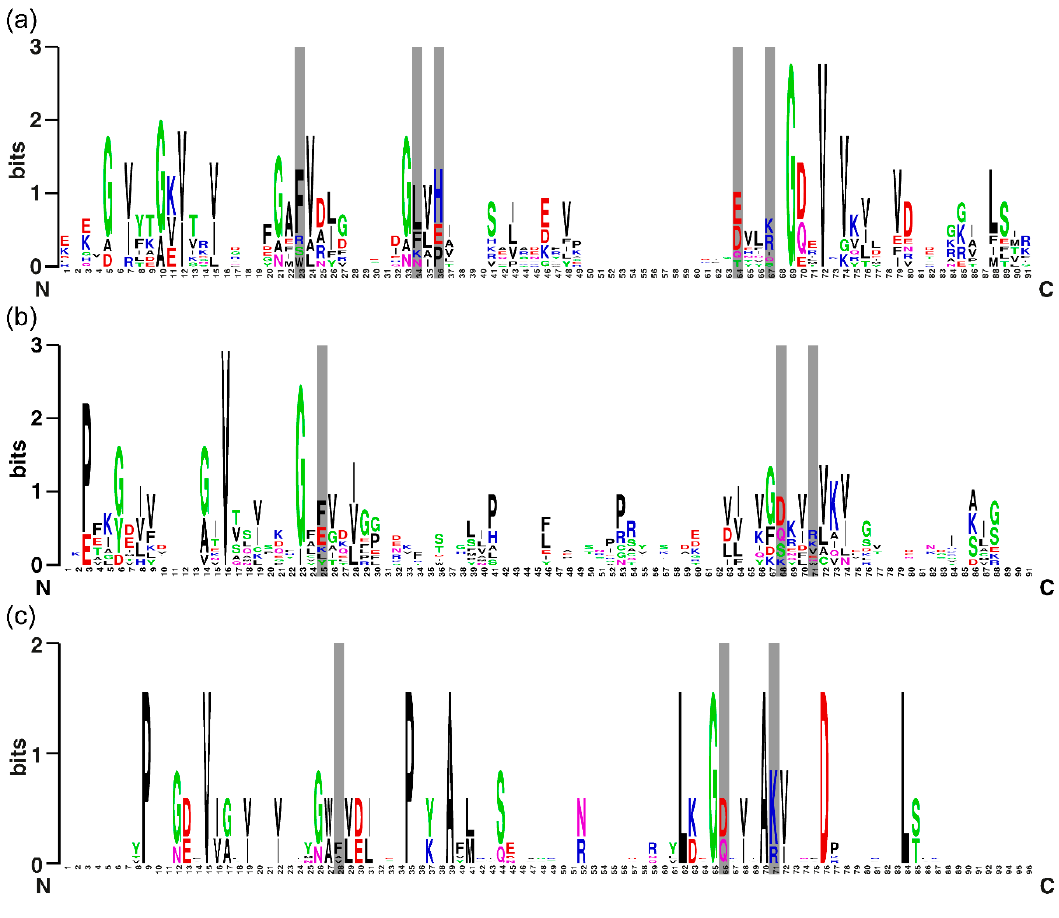
Figure 2. Sequence LOGO of the S1 domains for nine sequences from Bacteria ( a ), ten sequences from Eukaryotes ( b ), and five sequences from Archaea ( c ). Each LOGO is displayed in stacks of letters at each position. The total stack height is the information content of this position in bits. The height of individual letters in a stack is the probability of a letter in this position. The positions of conserved RNA-binding residues are highlighted.